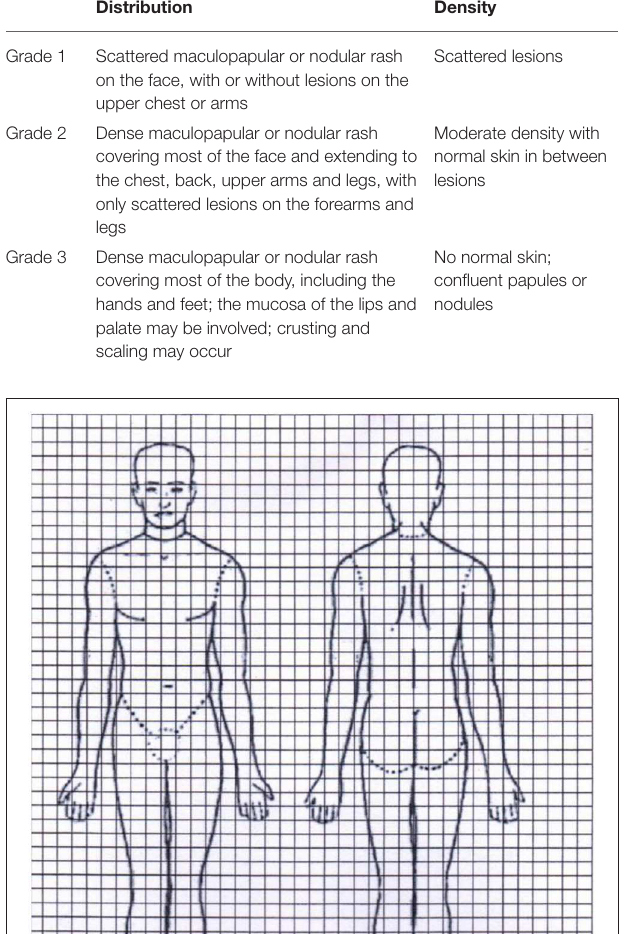
Monitoring During Treatment or